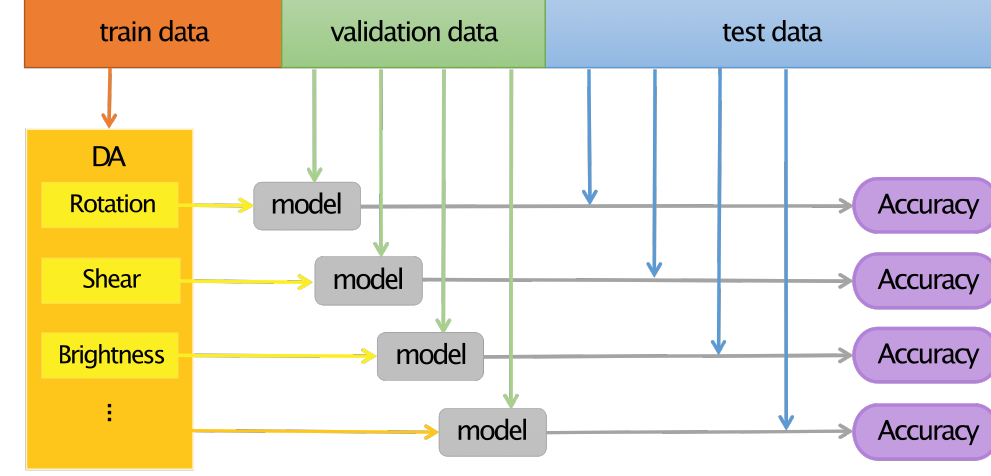
Figure 6. Flowchart of the work. Each DA method was applied to each train data and an individual model was trained and optimized using the validation data. The accuracy of the individually trained model was evaluated using the test